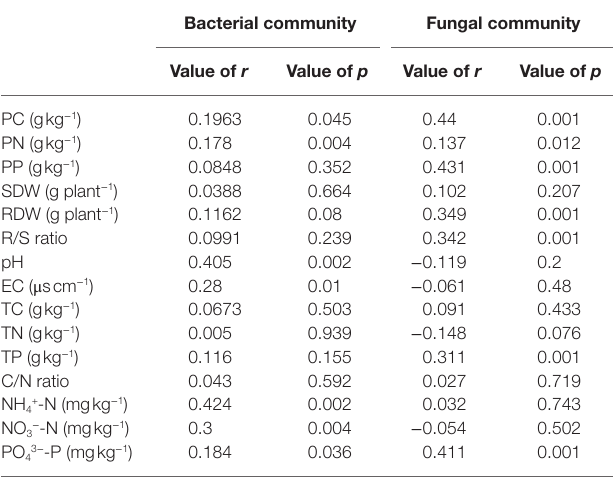
TABLE 1 | The Mantel test (permutations = 999) among plant traits, soil properties, and soil microbial communities. Bacterial community Fungal